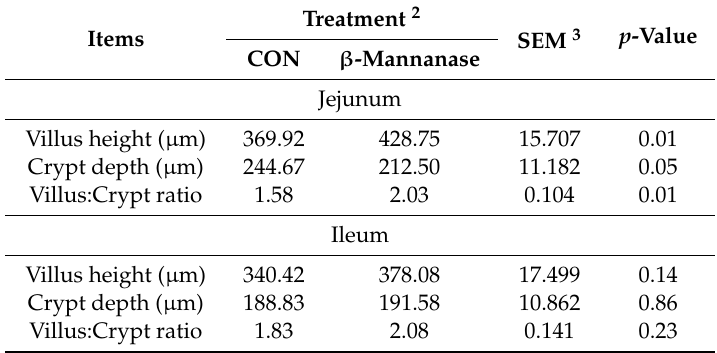
Table 4. Effects of dietary supplementation of β -mannanase on intestinal morphology of weaning pigs 1 . Items